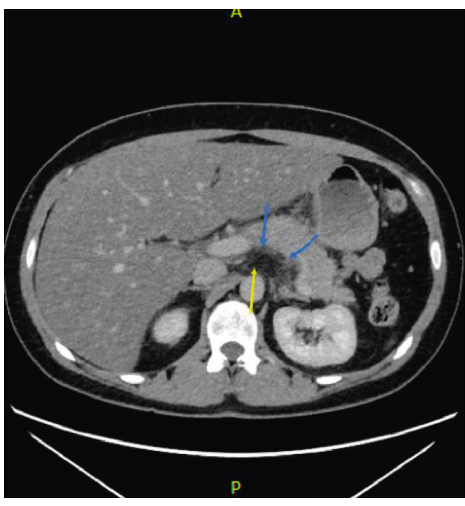
Figure 1: CTabdomen. CTillustrates the blurring of the margins of the pancreas (blue arrows) as well as mild retroperitoneal fat stranding (yellow arrows). These findings are due to inflammation of the fat around the pancreas, which is consistent with the di- agnosis of acute interstitial